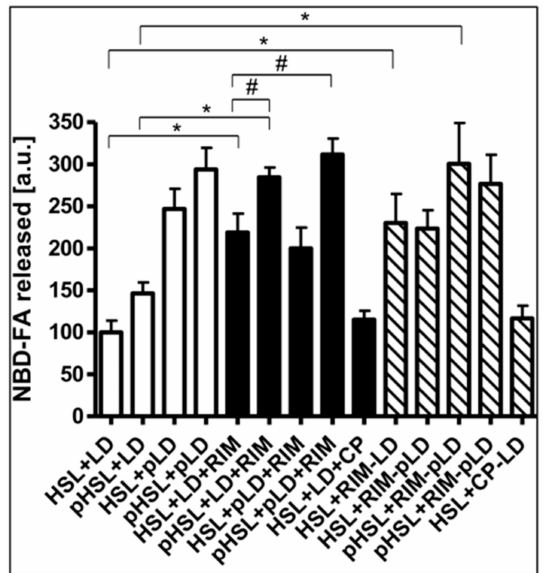
Figure 11. E ff ect of phosphorylation of HSL / LD on Rimonabant-induced lipolysis in the cell-free system. LD prepared from untreated (open, filled, hatched bars; LD) or Rimonabant (10 µ M, 3 h, 37 ◦ C)-treated (RIM-LD) or CP55.490-treated (50 µ M; CP-LD) primary rat adipocytes, which had been metabolically labelled with NBD-FA, were incubated (30 min, 30 ◦ C) with ATP in the presence (pLD) or absence (LD) of PKA catalytic subunit. Recombinant human HSL was incubated (30 min, 4 ◦ C) with ATP in the presence (pHSL) or absence (HSL) of PKA catalytic subunit. After termination of the reactions and recovery of the LD and HSL, they were reconstituted as indicated and then incubated (90 min, 30 ◦ C) in the presence or absence of 10 µ M Rimonabant (RIM) or 50 µ M CP55.490 (CP). After extraction of the total incubation mixtures with chloroform / methanol / HCl, the organic phases were analyzed by TLC. The amounts of NBD-FA lipolytically released from the NBD-FA-labelled AG1–4 were quantitatively evaluated by fluorescence imaging (mean ± SD of incubations in quadriplicate and TLC analysis in duplicate. NBD-FA released in the “HSL + LD” (absence of Rimonabant during cell-free lipolysis and adipocyte incubation, respectively) was set at 100. Values from corresponding reactions lacking exogenously added HSL were subtracted in each case in order to correct for HSL copurifying with the LD. Thus, the lipolysis activity depicted as NBD-FA released relies on the exogenously added recombinant human HSL rather than endogenous LD-associated rat HSL. * p ≤ 0.01, # p ≤